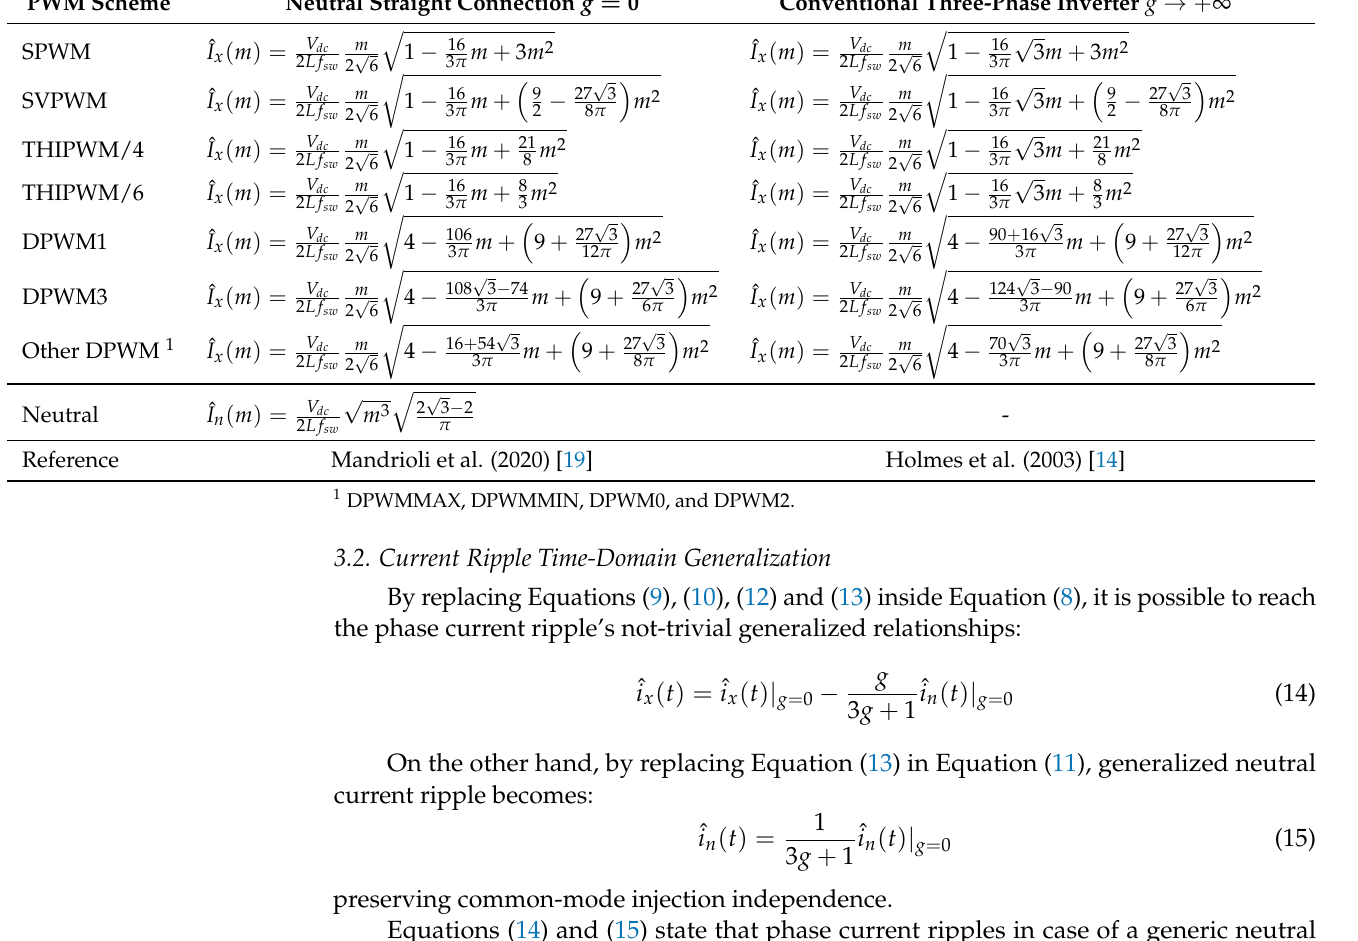
Table 2. Phase and neutral-current-ripple RMS in the case of g = 0 and g